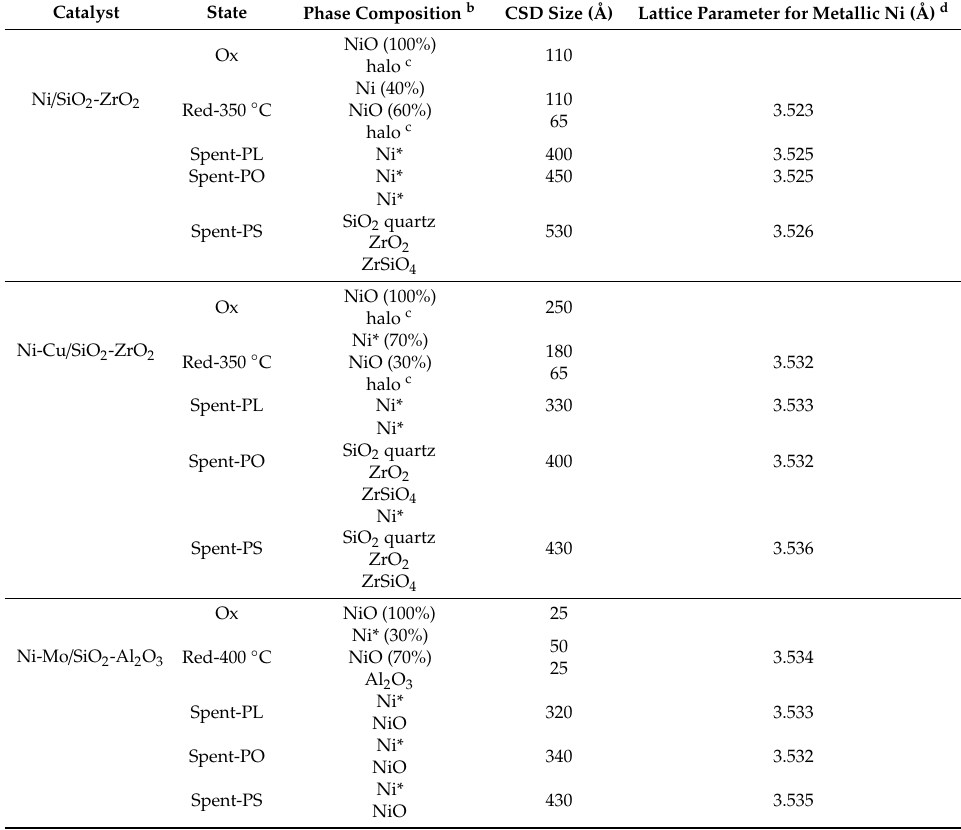
Table 8. X-Ray di ff raction data of fresh oxidized, reduced and spent catalysts Ni / SiO 2 -ZrO 2